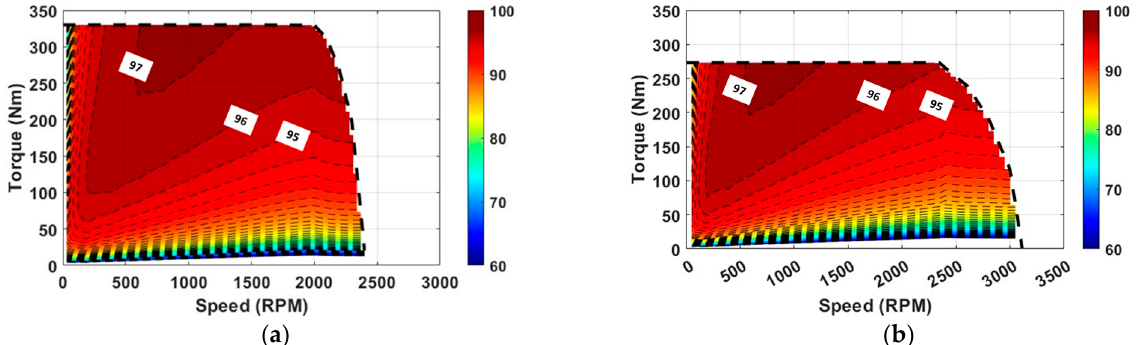
Figure 5. Efficiency maps at room temperature (20 °C) without considering EM–thermal coupling: ( a ) modular machine; ( b ) non-modular machine.